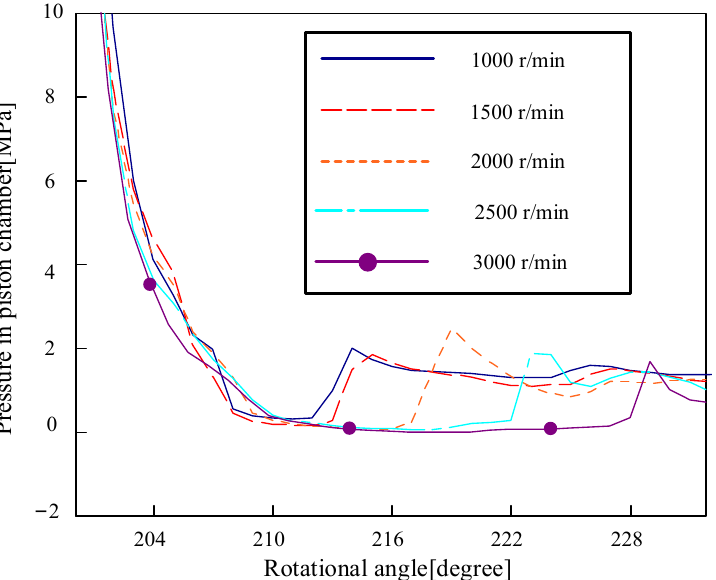
Figure 17. Pressure in the piston chamber with different rotational speeds at the beginning of the suction phase.